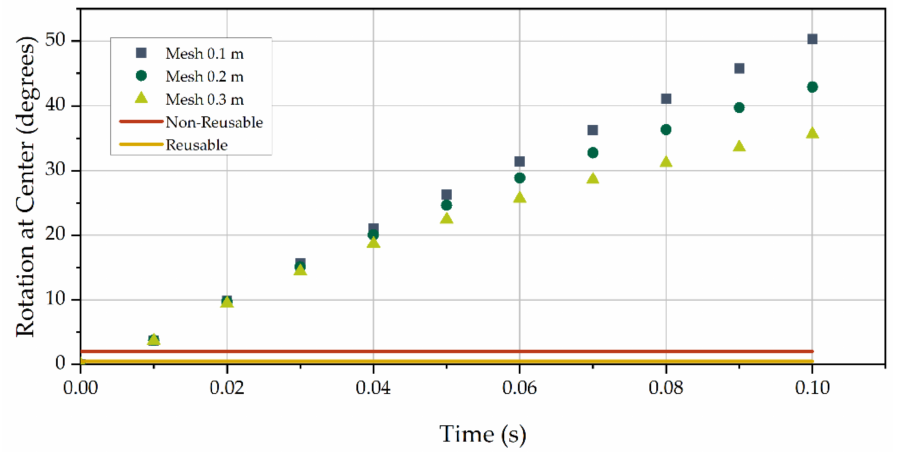
Figure 14. Time history of the rotation of the wall for different mesh sizes.